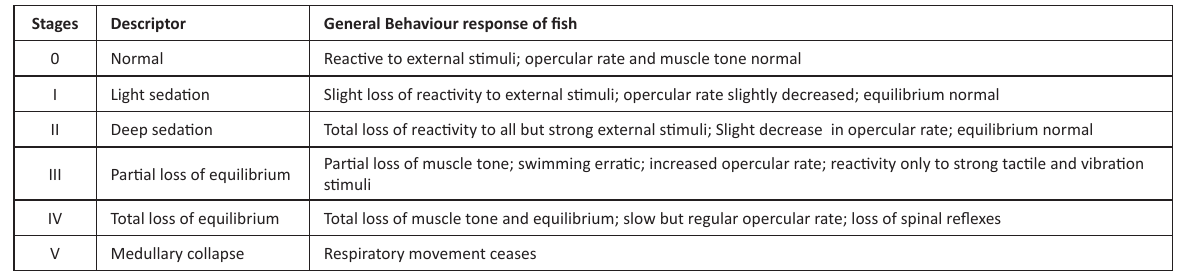
Table 2. Stages of anaesthetic induction (after Bowser 2001)